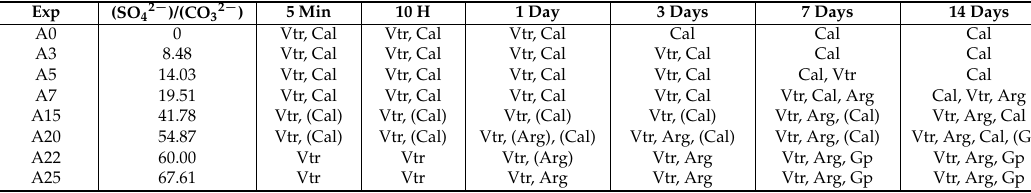
Table 2. The mineral identity of the solid phases recovered in each experiment after different ageing times: Note that the phases in brackets indicate that they are very scarce but that they are unequivocally identified at least in one of the analytical techniques